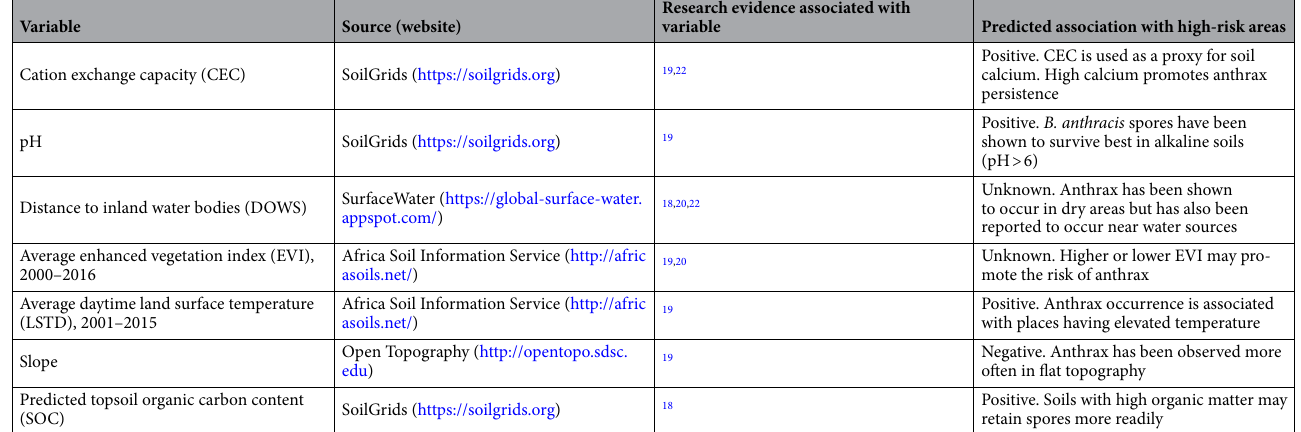
Table 1. Environmental factors with potential to influence anthrax occurrence. Data were obtained for Tanzania in